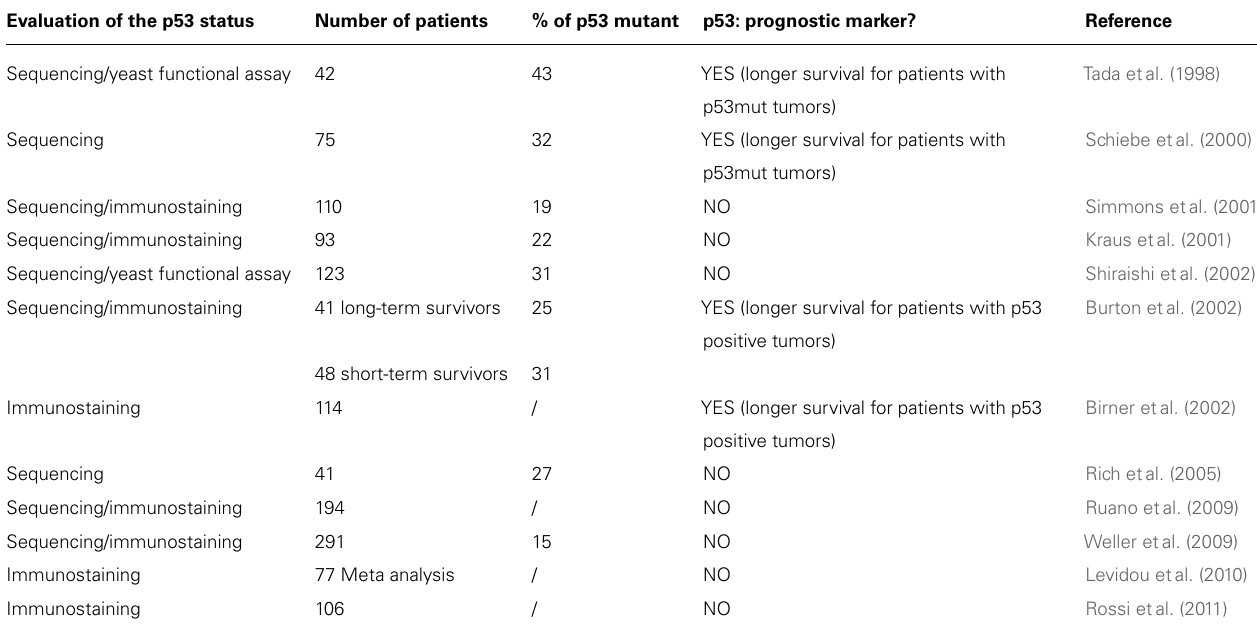
Table 1 | Evaluation of p53 status in glioblastoma.